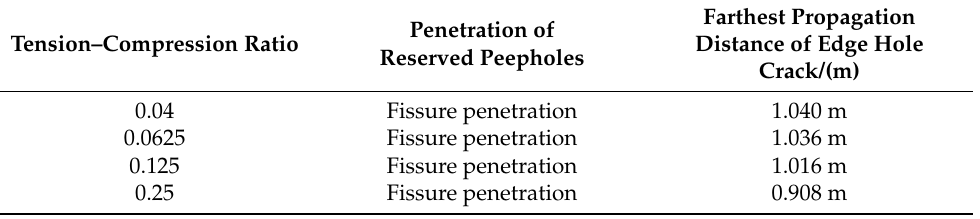
Table 7. Penetration propagation of blasting cracks with different tension–compression ratios.